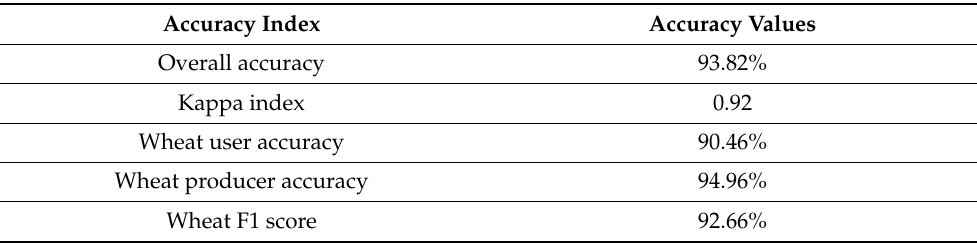
Table 6. Overall accuracy, Kappa index, wheat user and producer accuracy, and F1 score of the classification result.